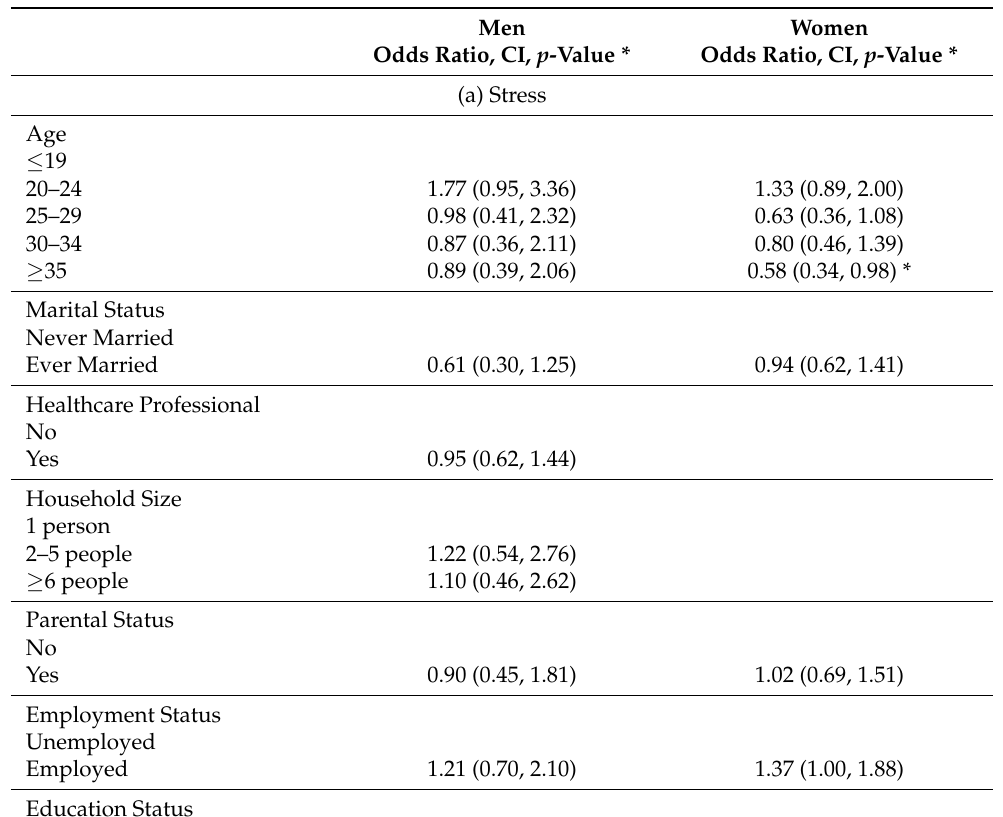
Table 5. Factors associated with psychosocial well-being among men and women (adjusted